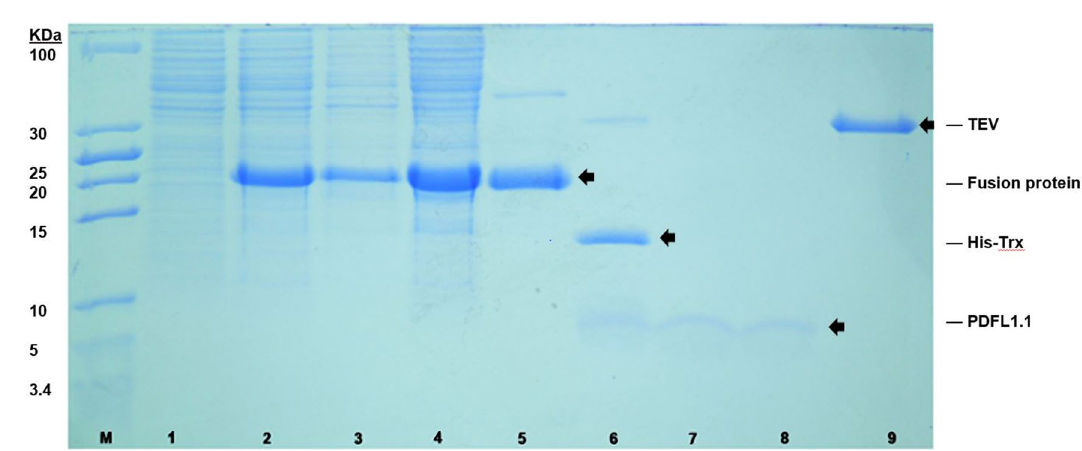
Figure 6. Purification of PDFL1.1. 1: Uninduced crude fraction, 2: Induced crude fraction, 3: Insoluble fraction, 4: Total soluble protein, 5: Elution after purification, 6: Digestion of the purified fusion protein